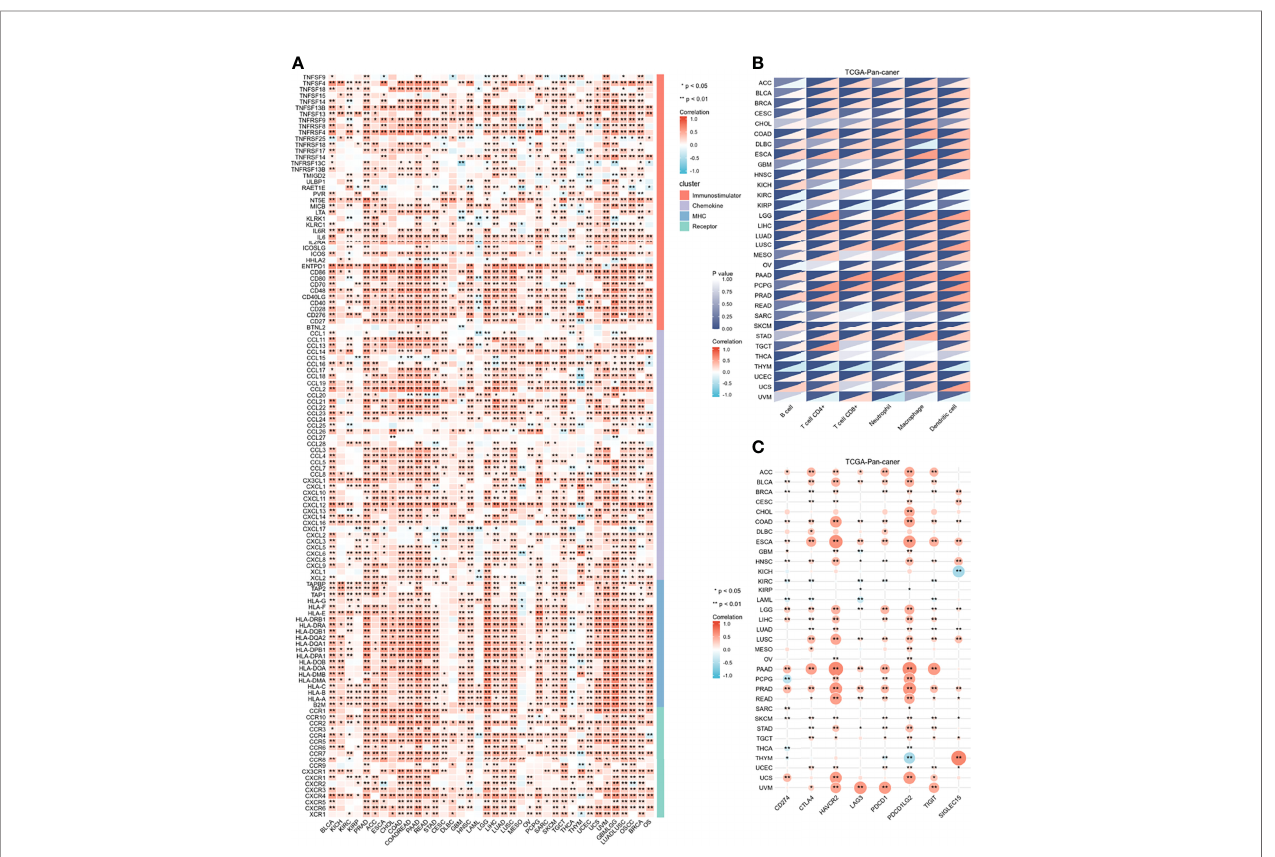
FIGURE 1 | Immunological role of IGFBP7 in Pan-cancer. (A) correlations between the expression of IGFBP7 and immunomodulators (immunostimulatory, chemokine, MHC, receptor). (B) correlations between the expression of IGFBP7 and tumor in fi ltrating immune cells. (C) correlations between the expression of IGFBP7 and immune check point. The value of the correlation coef fi cient is represented by the intensity of blue or red, as indicated on the color scale. The asterisks indicate signi fi cant differences calculated using spearman correlation analysis. (*p < 0.05; **p <